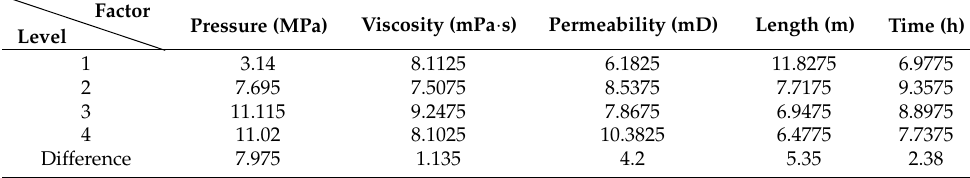
Table 5. Results of the range method